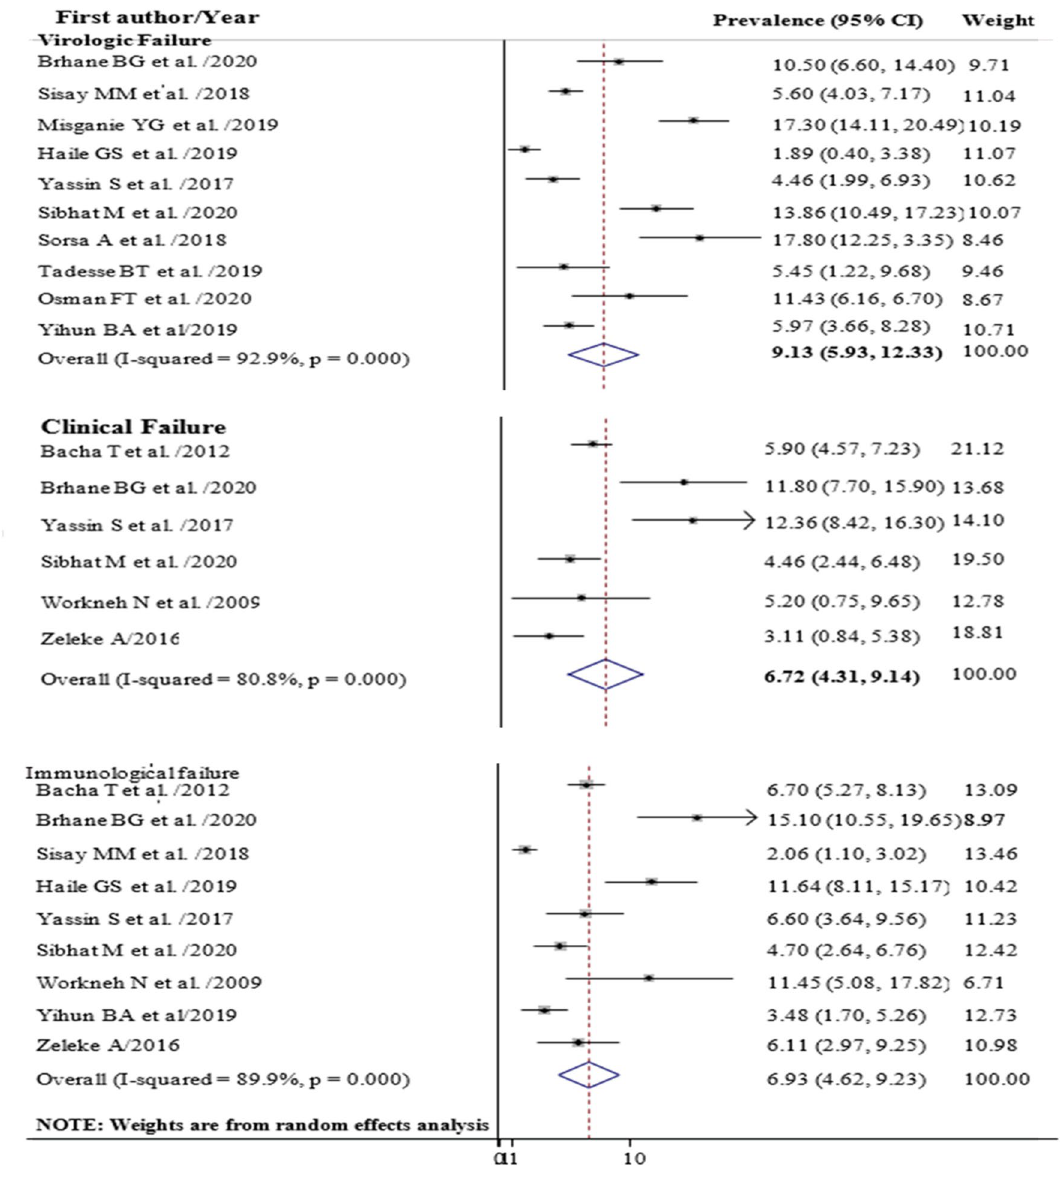
Figure 3. Forest plot showing the prevalence of virologic, clinical and immunological treatment failure among children in Ethiopia, 2020.